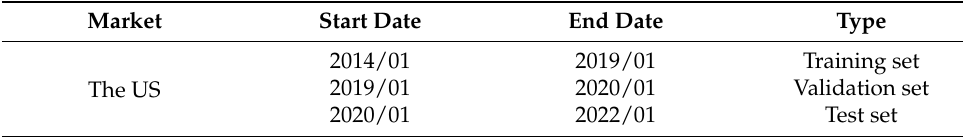
Table 2. Training, validation, and test